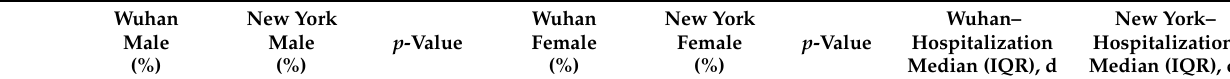
Table 3. Deaths by age and sex and hospitalization